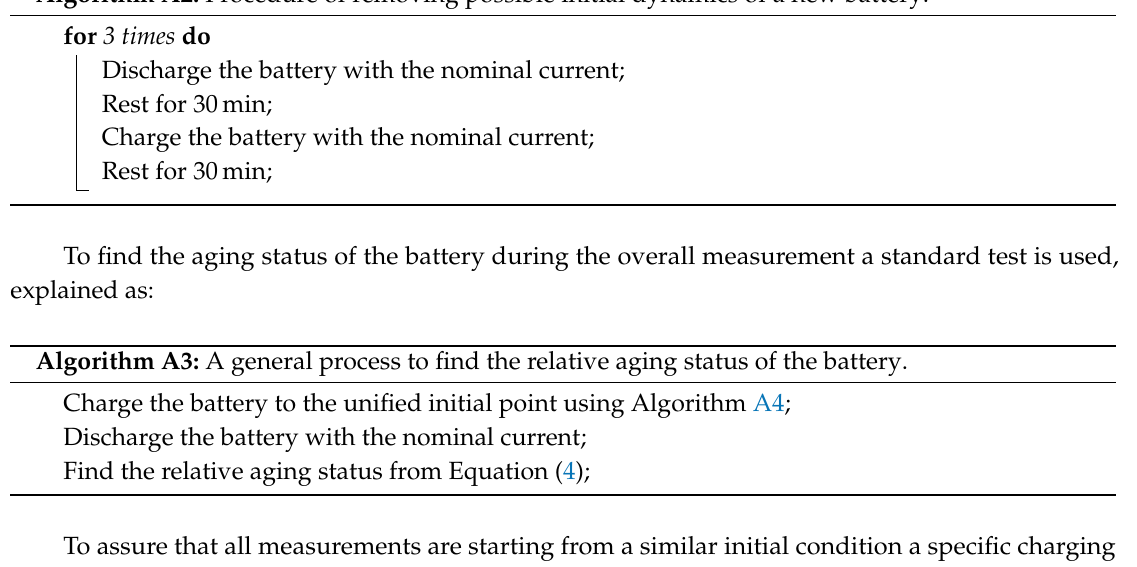
Algorithm A2: Procedure of removing possible initial dynamics of a new battery.